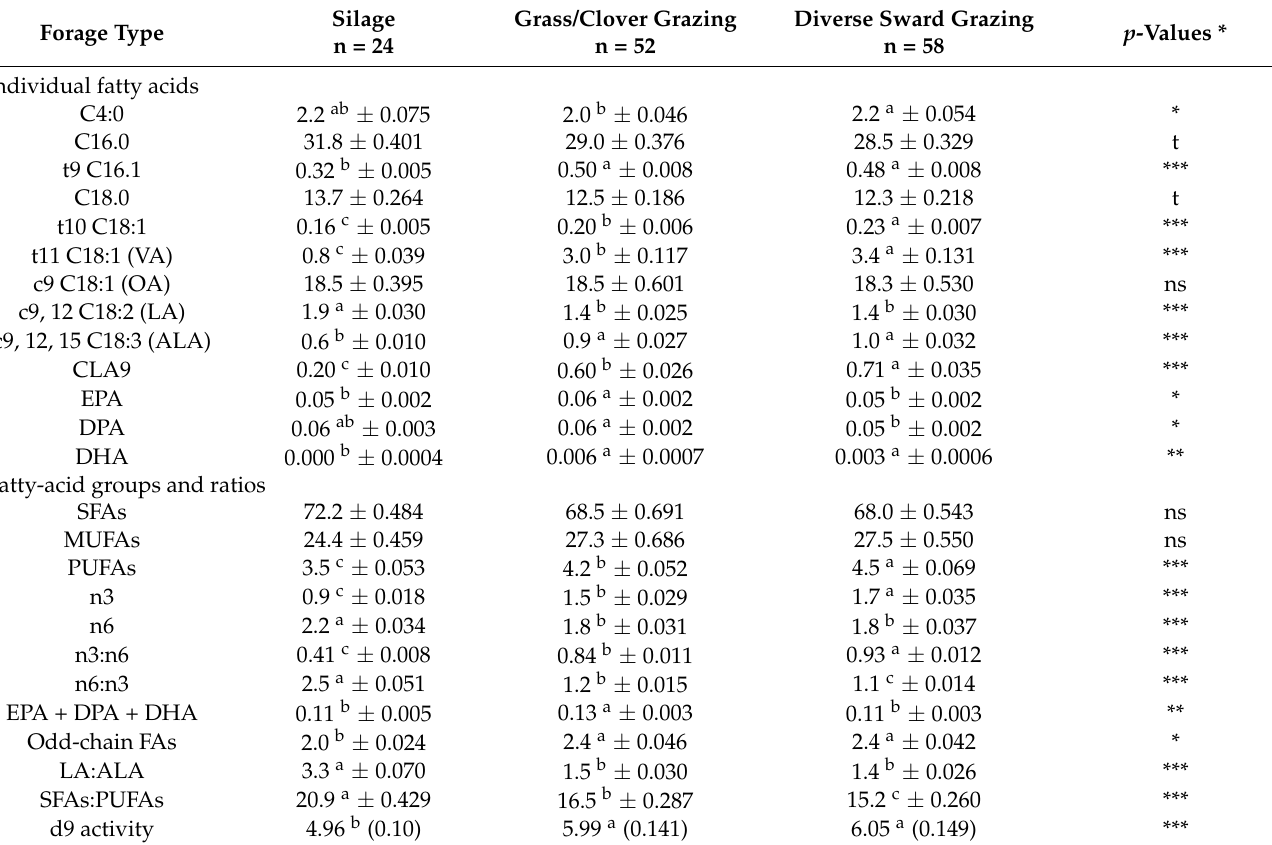
Table 1. Concentrations of individual, nutritionally relevant fatty acids in milk (mean values as % of total fatty acids ± standard error of means) and calculated values which differed between forage types (silage, grass/clover grazing, and diverse sward